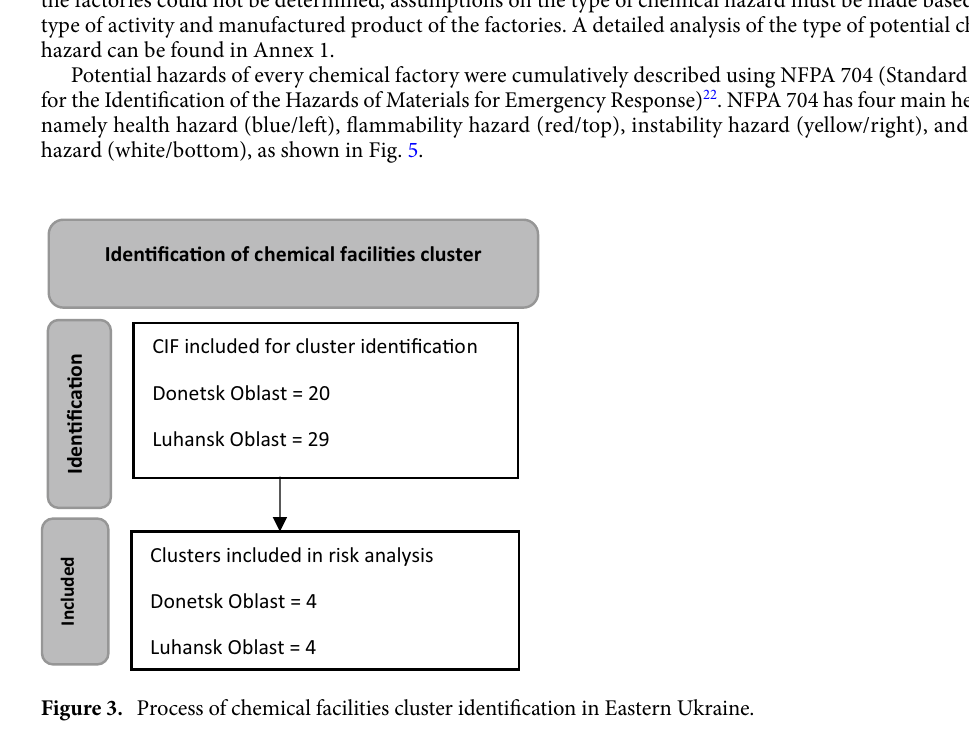
Figure 3. Process of chemical facilities cluster identification in Eastern Ukraine.